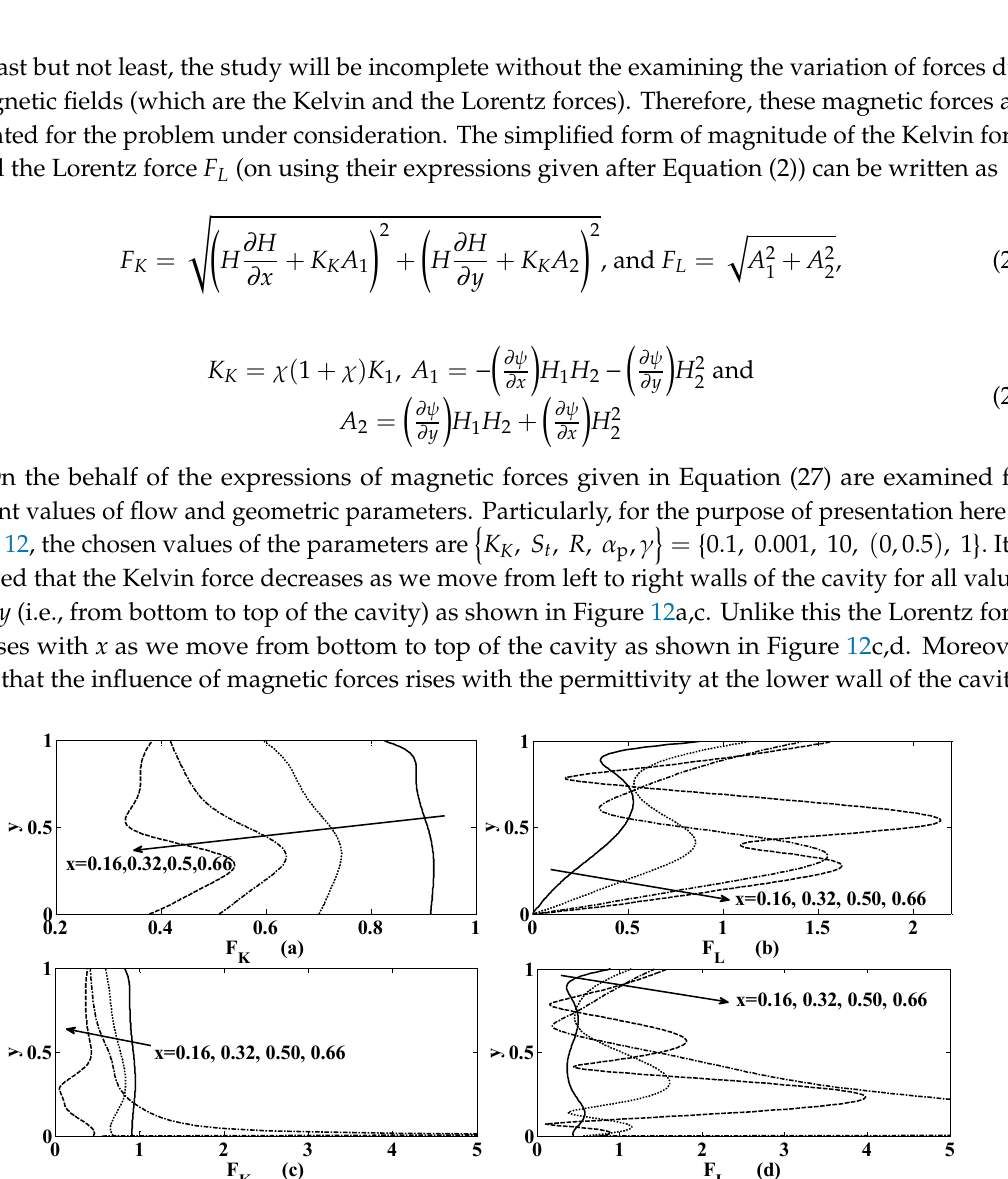
Figure 12. Variation of magnetic forces ( a ), ( c ) the Kelvin force di ff erent positions in the cavity as mentioned within the figure if ( b ) α p = 0 ( c ), ( d ) α p =